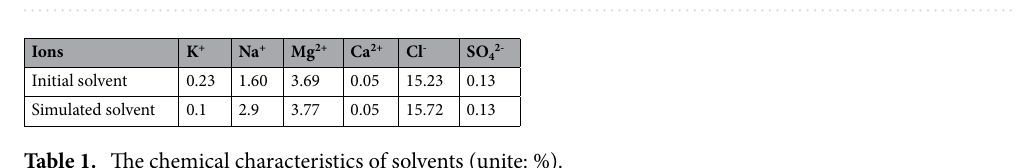
Table 1. The chemical characteristics of solvents (unite: %).